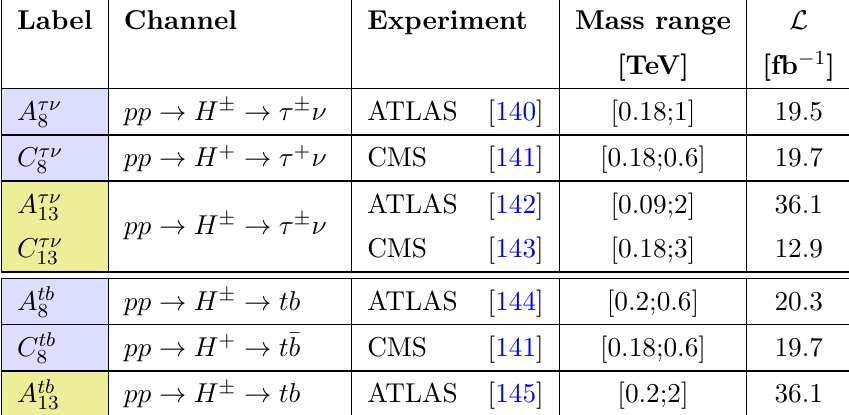
Table 5. Direct searches for charged